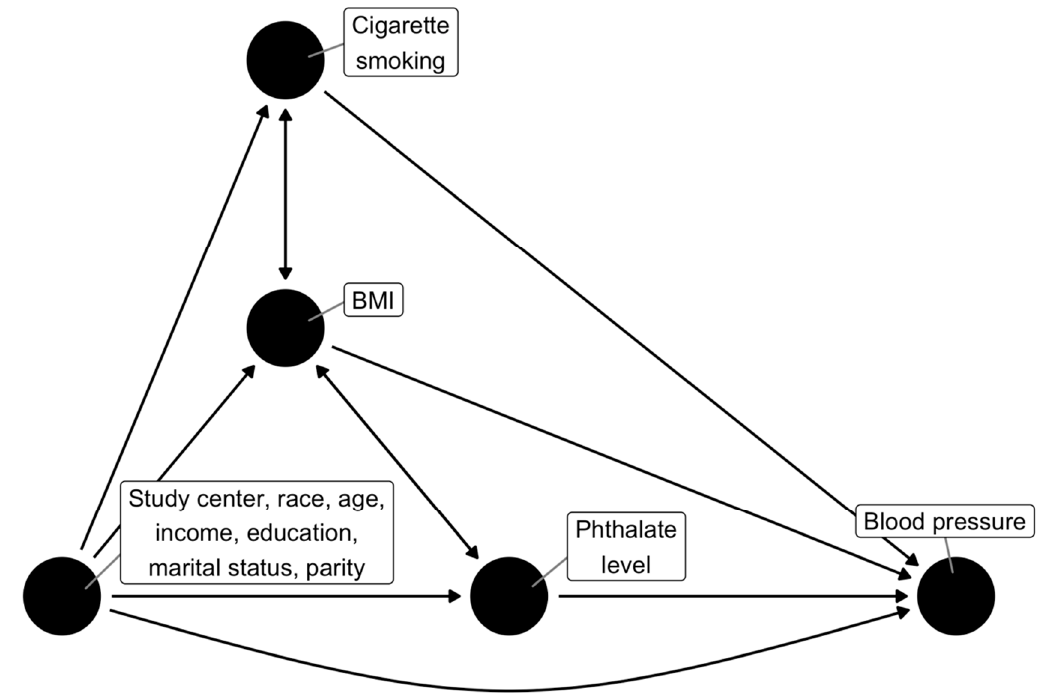
Figure 1. Hypothesized causal DAG for analysis of phthalate level and PIH. Double-headed arrows indicate a latent confounder. Table 1. Demographics and pregnancy characteristics of 738 pregnant women from The Infant Development and the Environment Study (TIDES), 2010–2012.